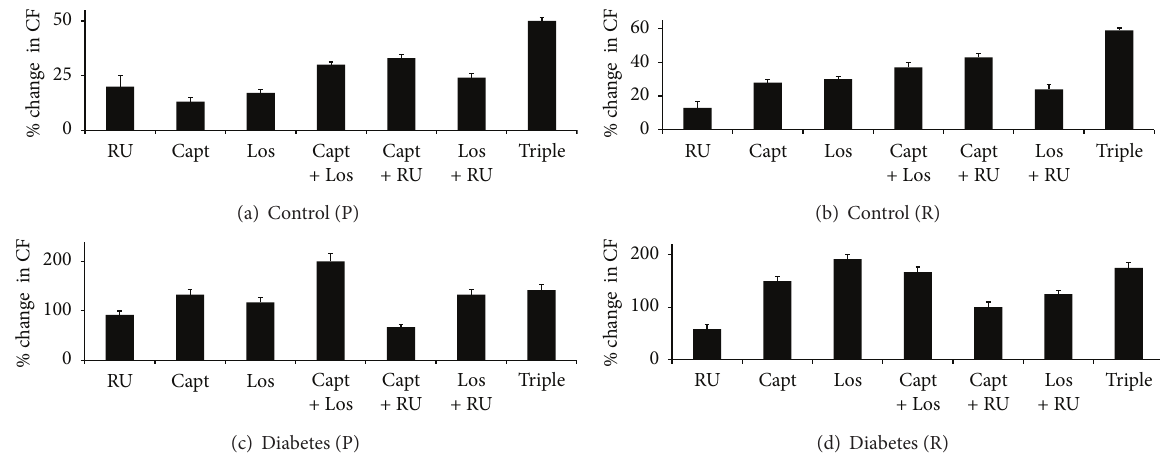
Figure 9: A comparison of the % change in coronary flow (CF) in control and diabetic hearts following acute treatment with various drug regimens. Drugs were given to control hearts during perfusion (a) or reperfusion (b) and to diabetic hearts during perfusion (c) or reperfusion (d). The percent change in parameter is calculated relative to the % recovery seen in the respective nondiabetic or diabetic controls. RU: RU28318; Capt: Captopril; Los: Losartan; Triple: RU28318 + Captopril +